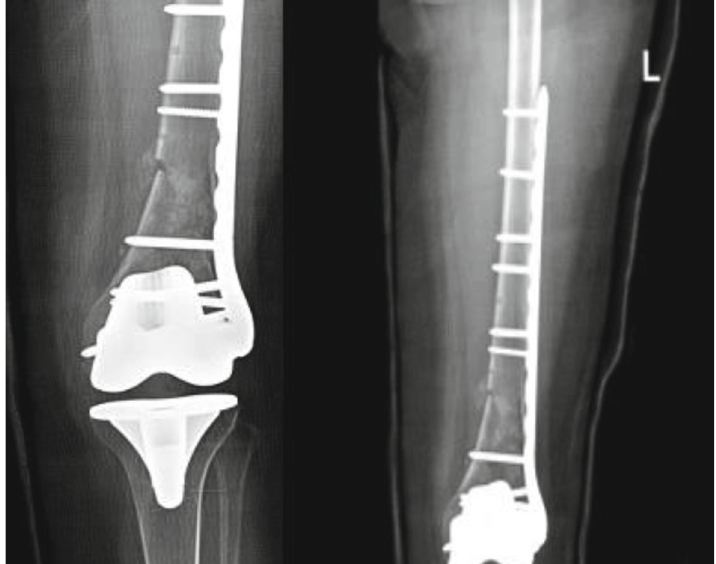
Figure 3: Postoperative follow-up A-P radiographs done one month postoperatively showing reduced fracture and beginning of callus formation in the distal femoral